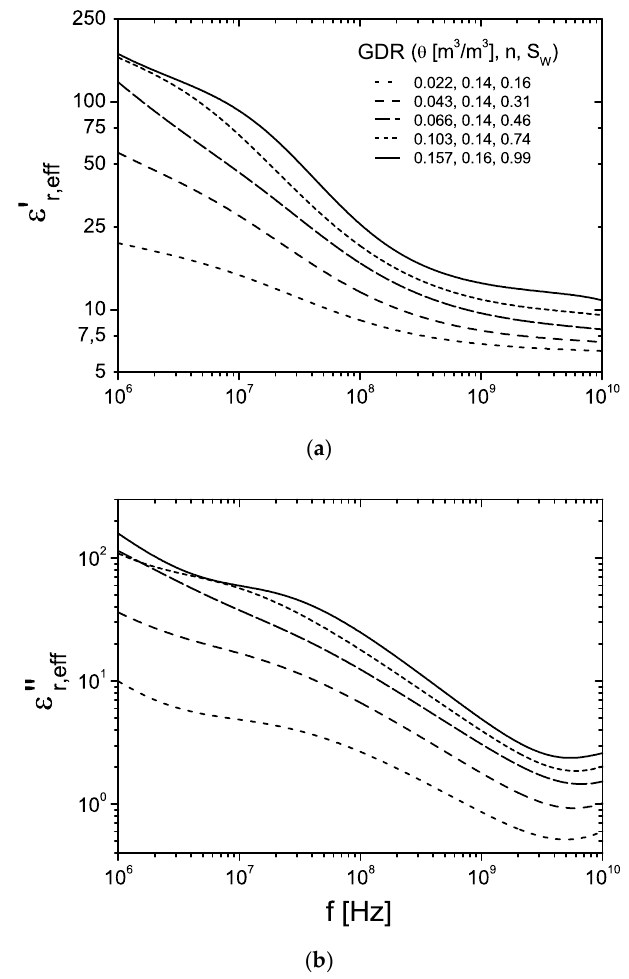
Figure 4. Dielectric input spectra of the clay rock for the numerical 3-D calculation as a function of frequency at defined states determined based on inverse modeling technique with the GDR. ( a ) Real part ( b ) Imaginary part.